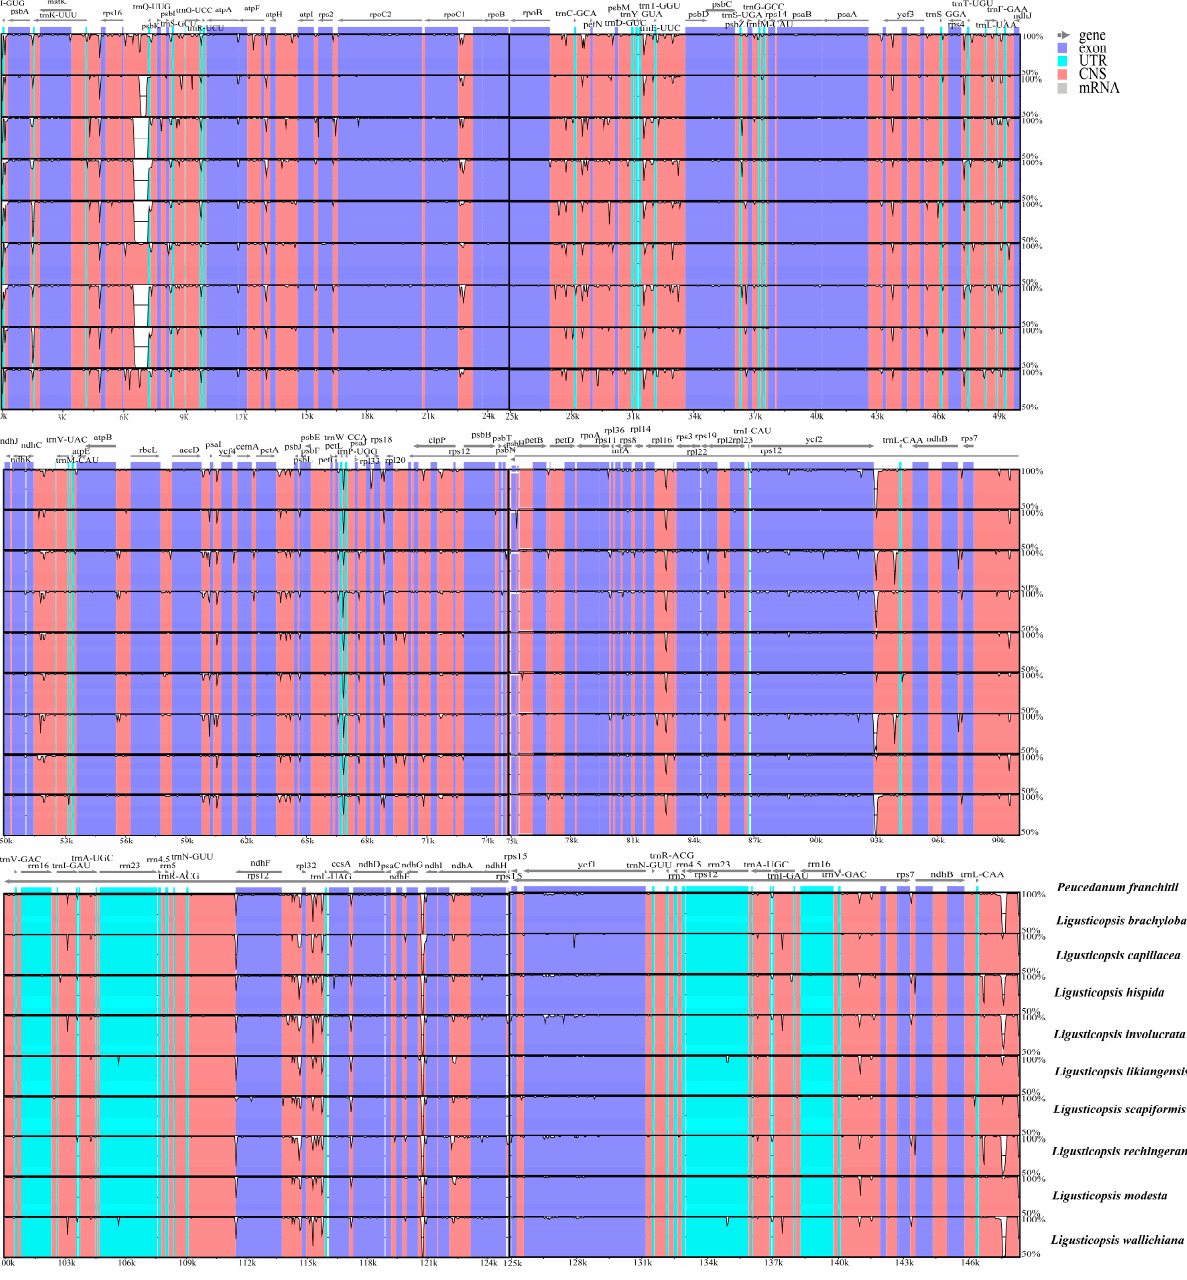
Figure 8. Sequence identity plot comparing the ten plastomes using mVISTA. The y-axis corresponds to percentage identity (50–100%), while the x-axis shows the position of each region within the locus. Arrows indicate the transcription of annotated genes in the reference genome.